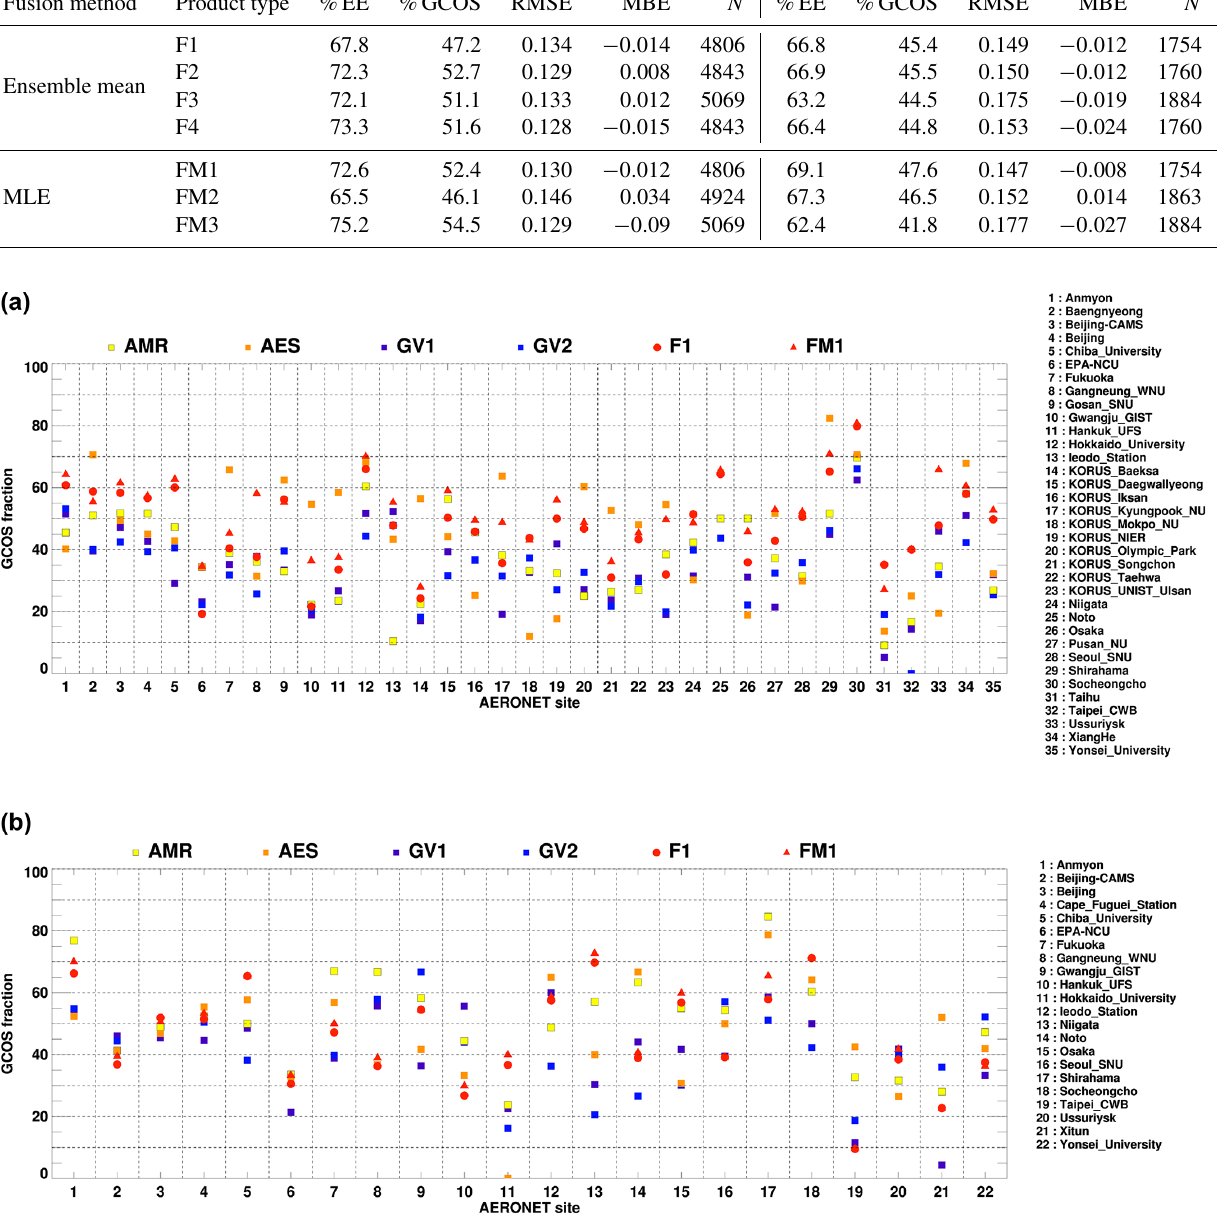
Figure 6. Comparison of the GCOS fraction for the respective satellite (AMR, AES, GV1, and GV2), ensemble-mean fusion (F1), and MLE fusion (FM1) during the (a) KORUS-AQ and (b) EMeRGe campaign. Colors represent different aerosol